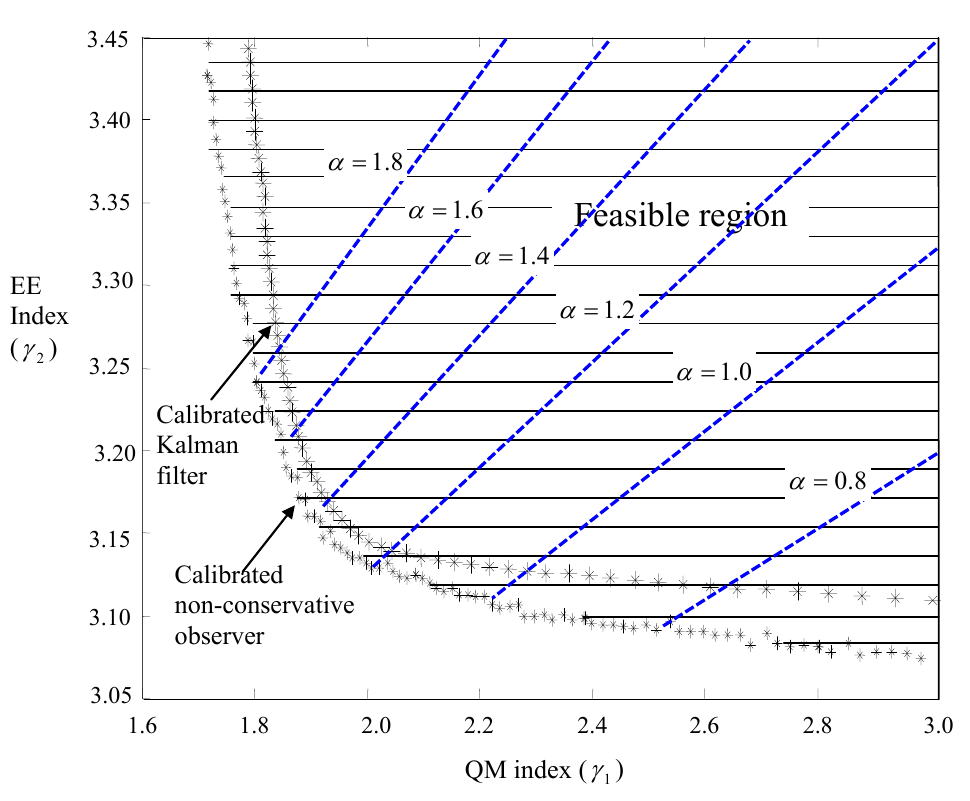
Figure 7. Improved trade-off between energy and motion